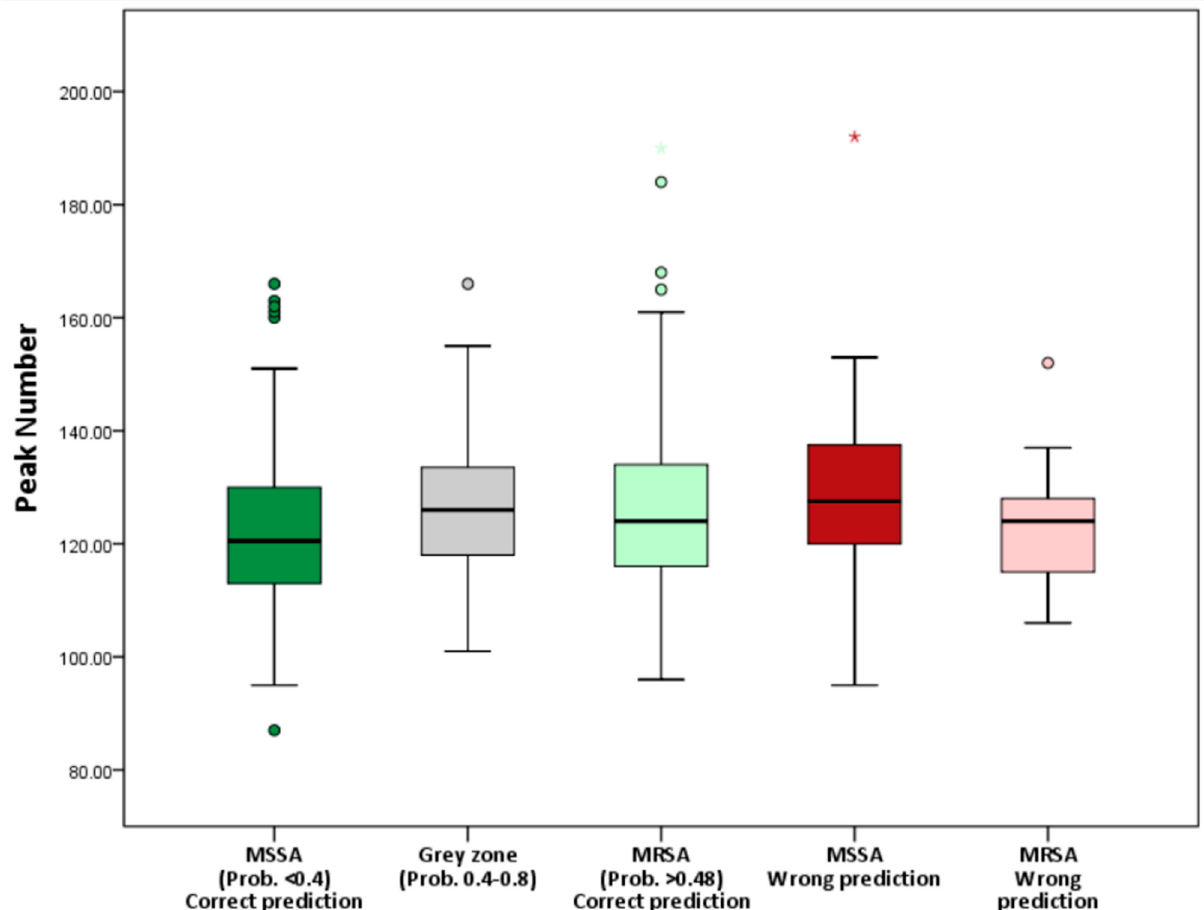
Figure 2. Number of peaks of the MALDI-TOF mass spectra in different groups. The number of peaks of different groups (i.e., MSSA with correct prediction, grey zone, MRSA with correct prediction, MSSA with wrong prediction, and MRSA with wrong prediction) shows no significant difference, indicating comparable quality of spectra between groups. Asterisk represents “extreme value”, which is more than 3 interquartile range (IQR) from the end of a box. Small circle represents “outliers”, which is more than 1.5 IQR but at most 3 IQR from the end of a box.